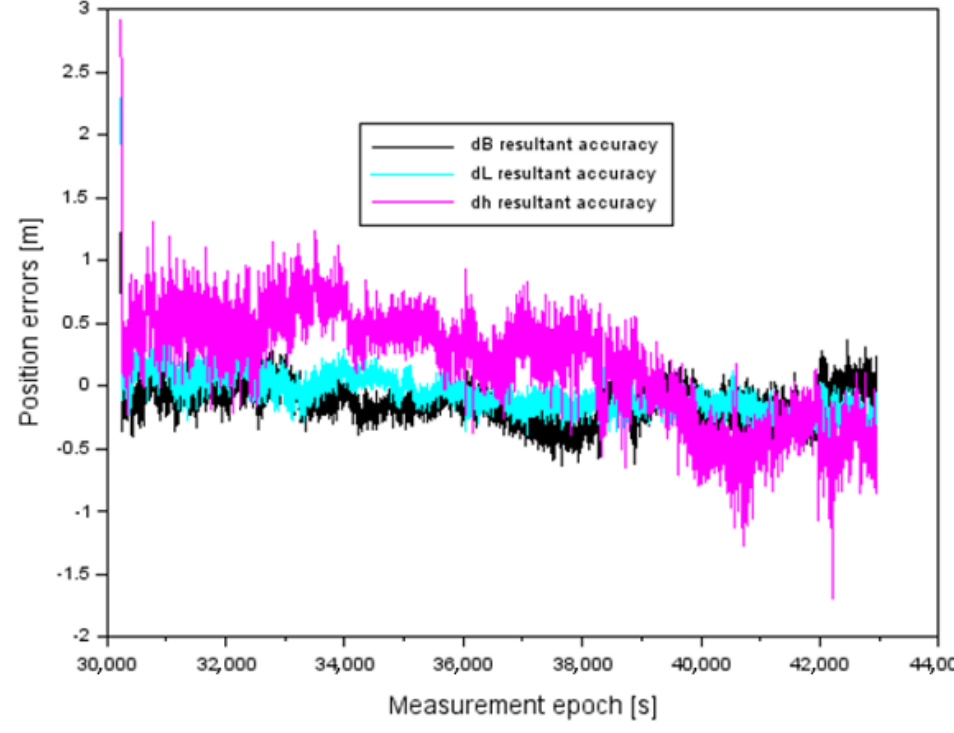
Figure 12. The resultant accuracy of (𝑑𝐵,𝑑𝐿,𝑑ℎ) parameters.